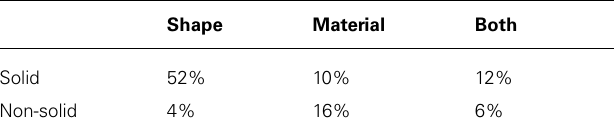
Table 2 | Noun categories based on adult judgments of solidity (solid or non-solid) and characteristic feature (shape, material, or both) for nouns in the MCDI vocabulary